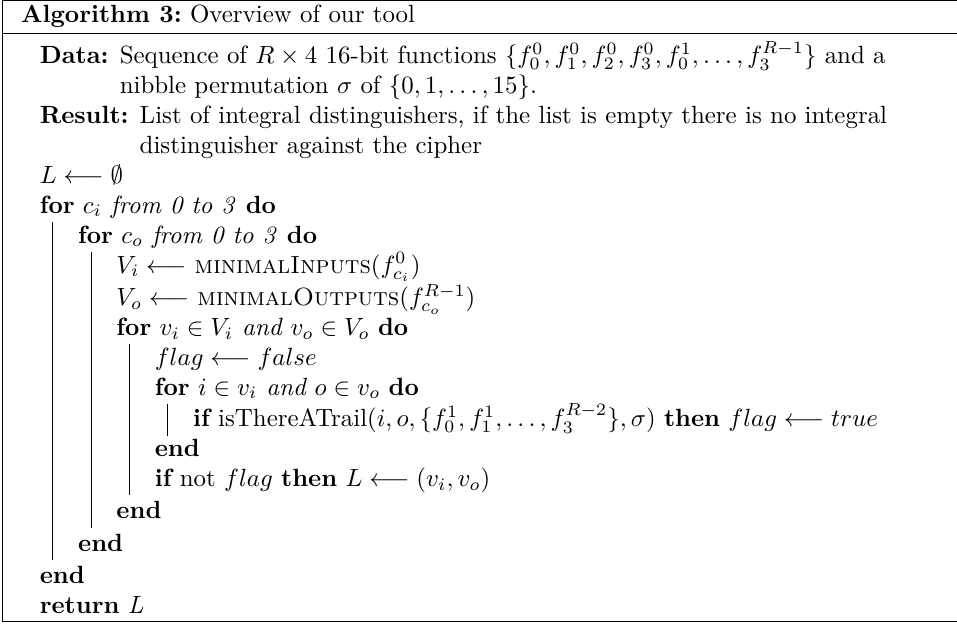
Algorithm 3: Overview of our